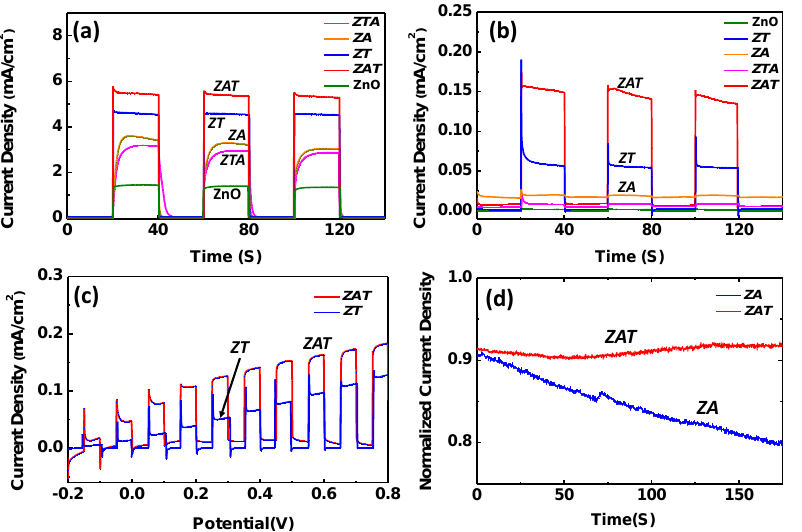
Figure 8. I-t curves with chopped ( a ) AM 1.5 light source and ( b ) visible light source ( λ ≥ 420 nm). ( c ) Linear-sweep voltammograms (LSV) of heterostructures under chopped visible light illumination. ( d ) Comparison of the photocurrent stability of ZAT and ZA samples.